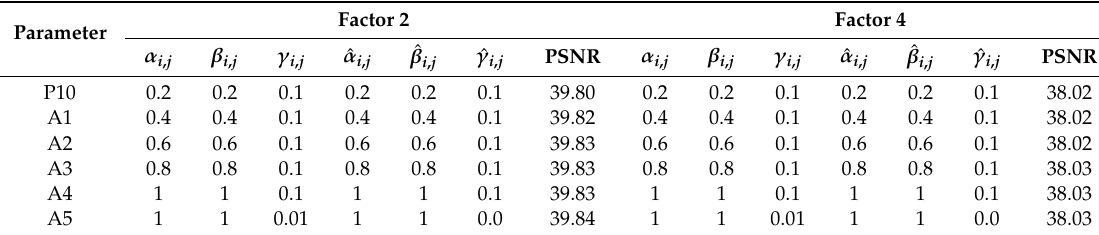
Table 6. The impact of parameter values on PSNR values.